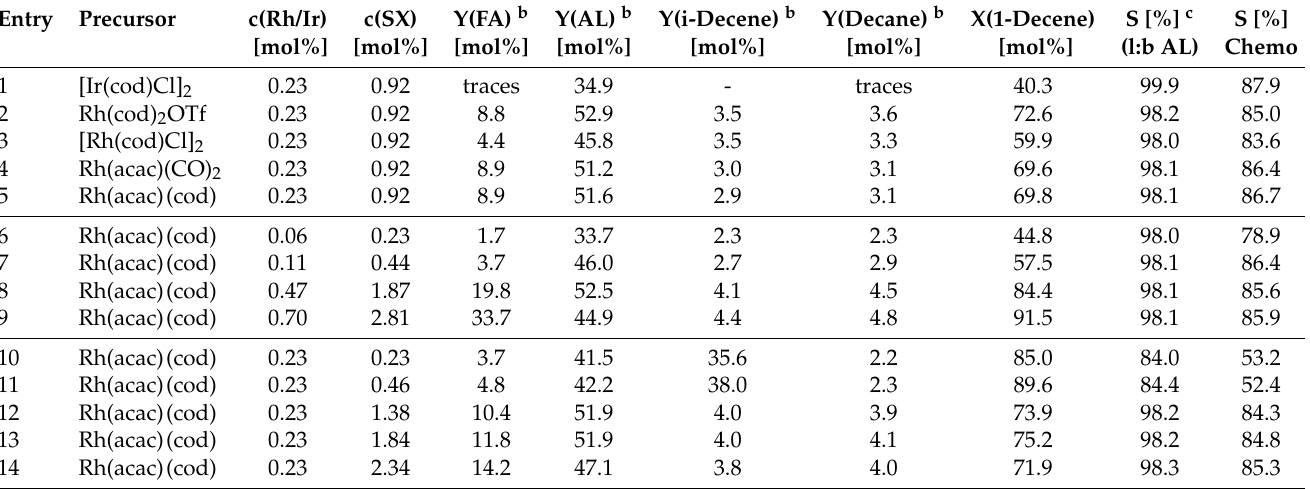
Table 1. Effect of Rh-precursor (upper section), its concentration (middle section) and ligand concen- tration (lower section) on the hydroaminomethylation performance a